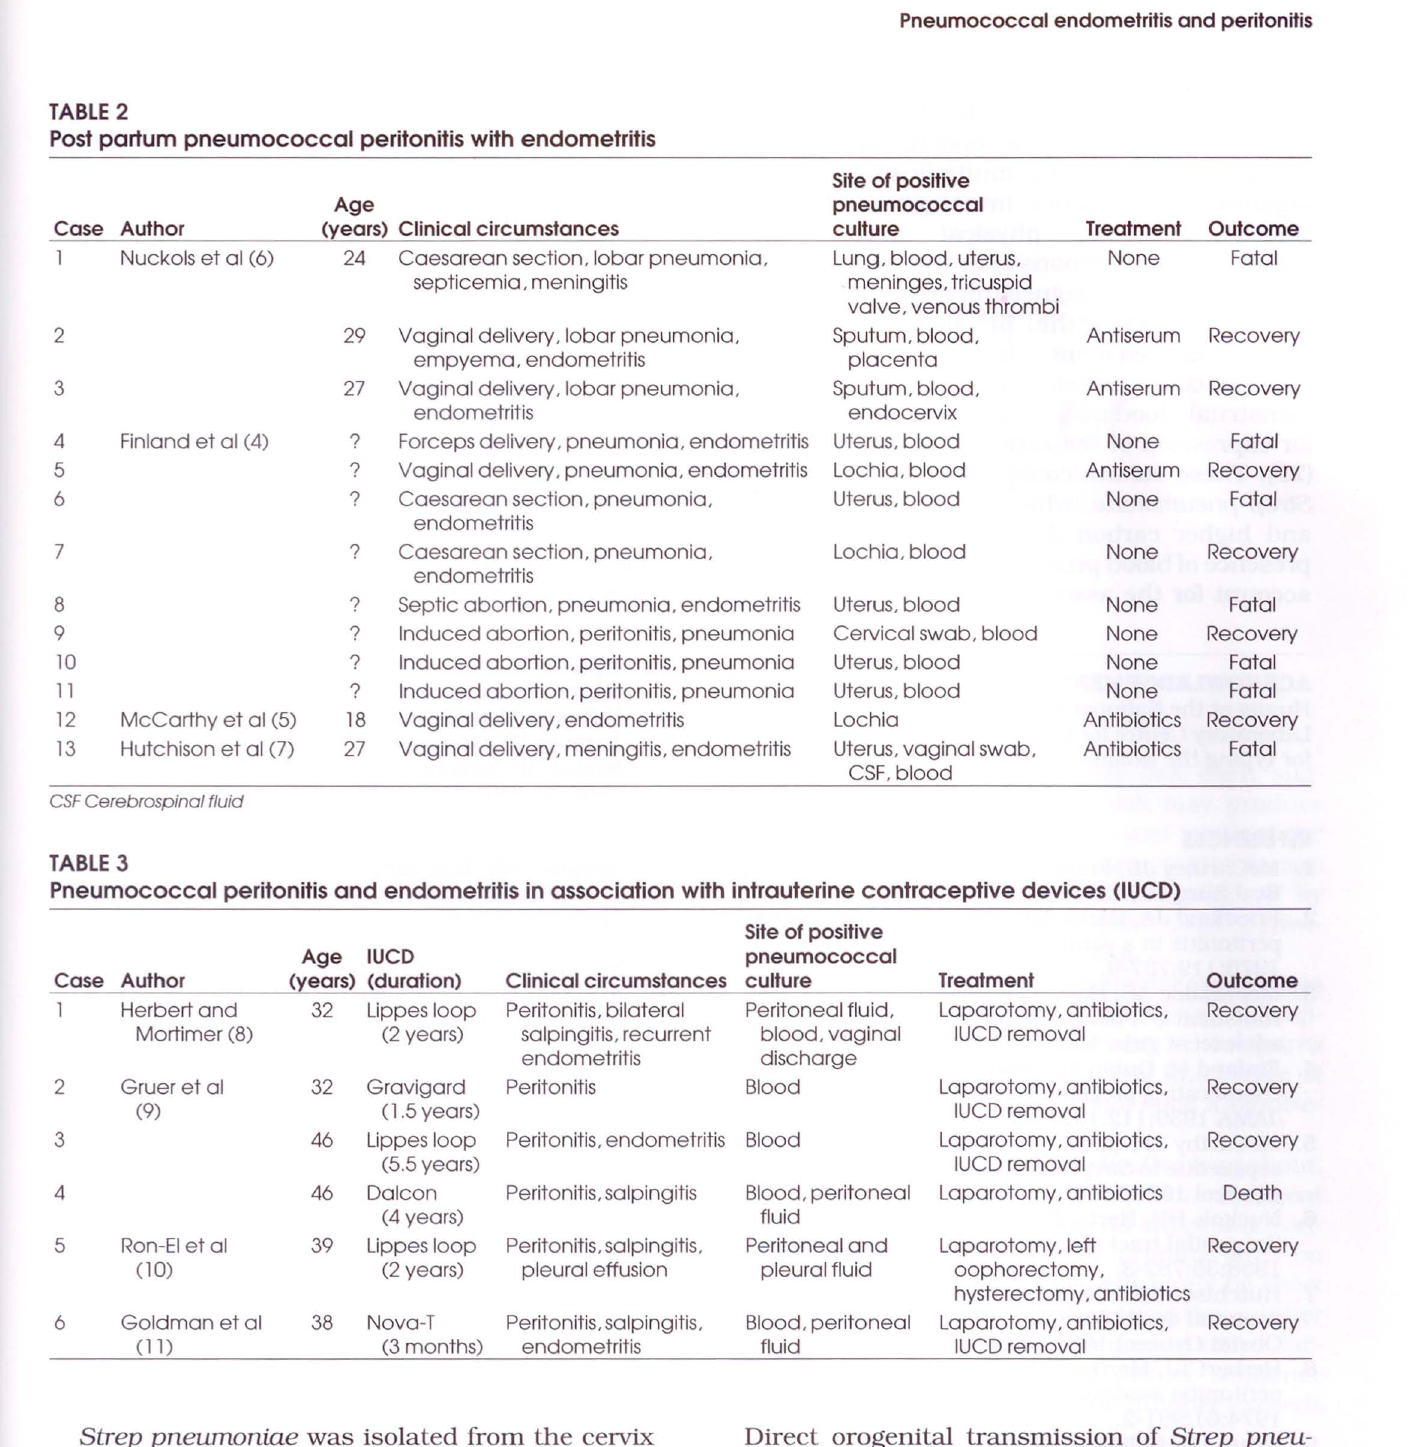
Pneumococcal peritonitis and endometritis in association with intrauterine contraceptive devices